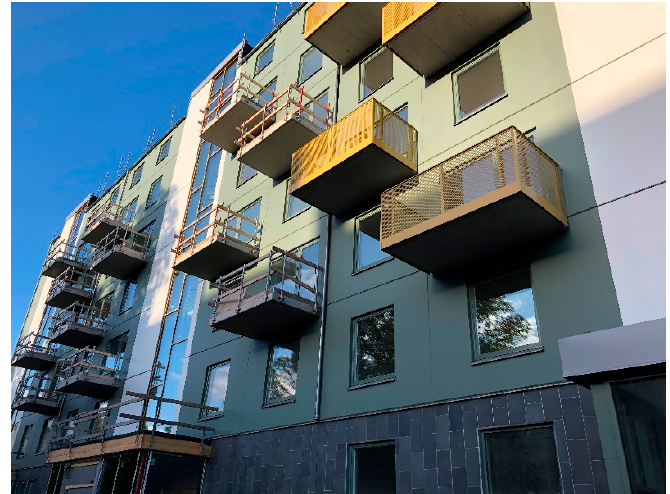
Figure 9. Example facade showing of some factors (e.g., balconies and windows) influencing the expected catch area.